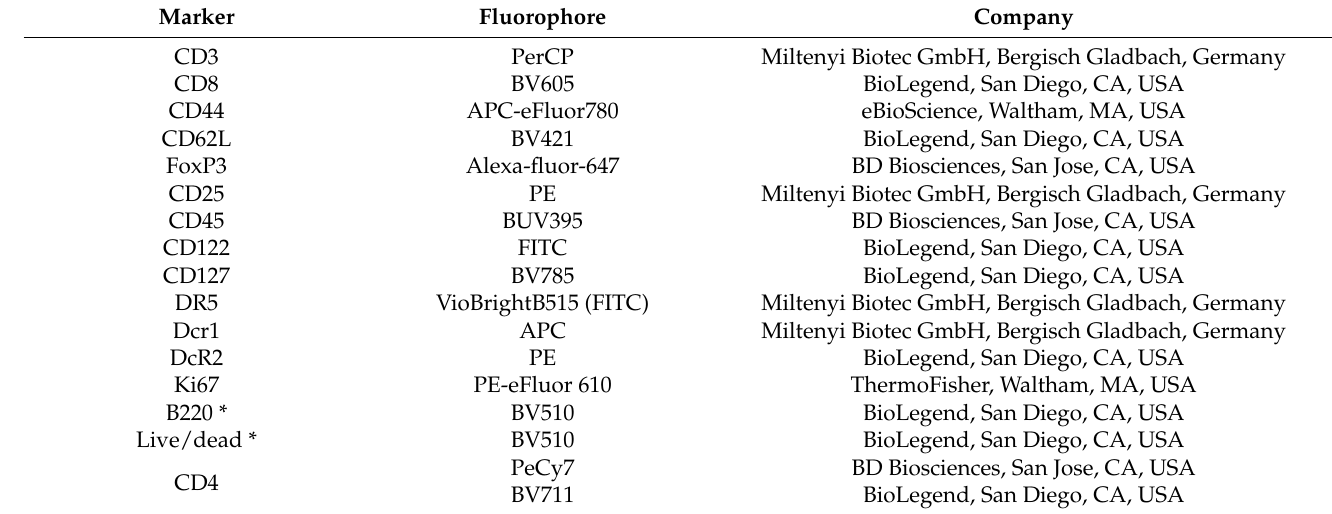
Table 1. List of the anti-mouse conjugated antibodies for immune cell analysis via